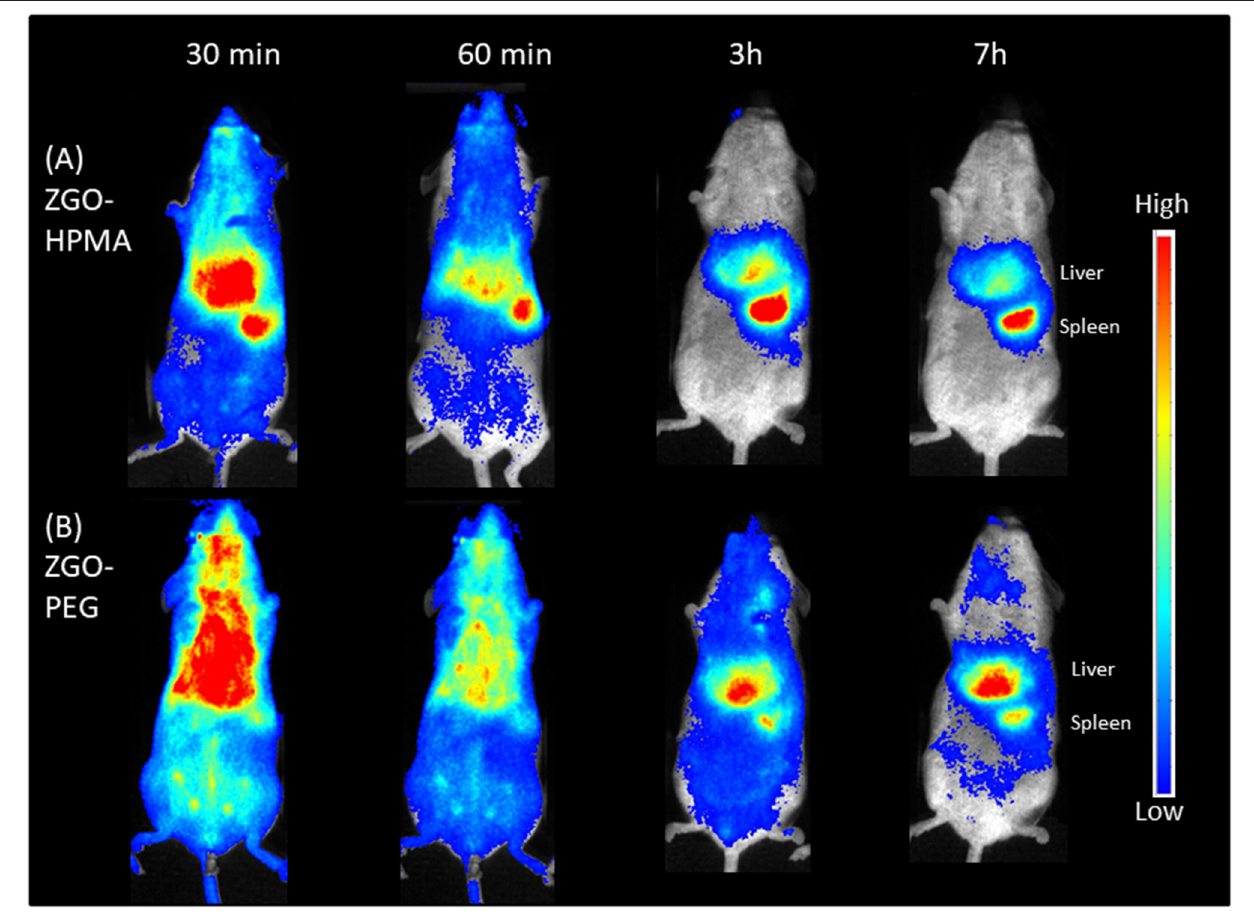
FIGURE 5 | In vivo biodistribution of coated ZGO in healthy mice. (A) ZGO-HPMA. (B) ZGO-PEG.